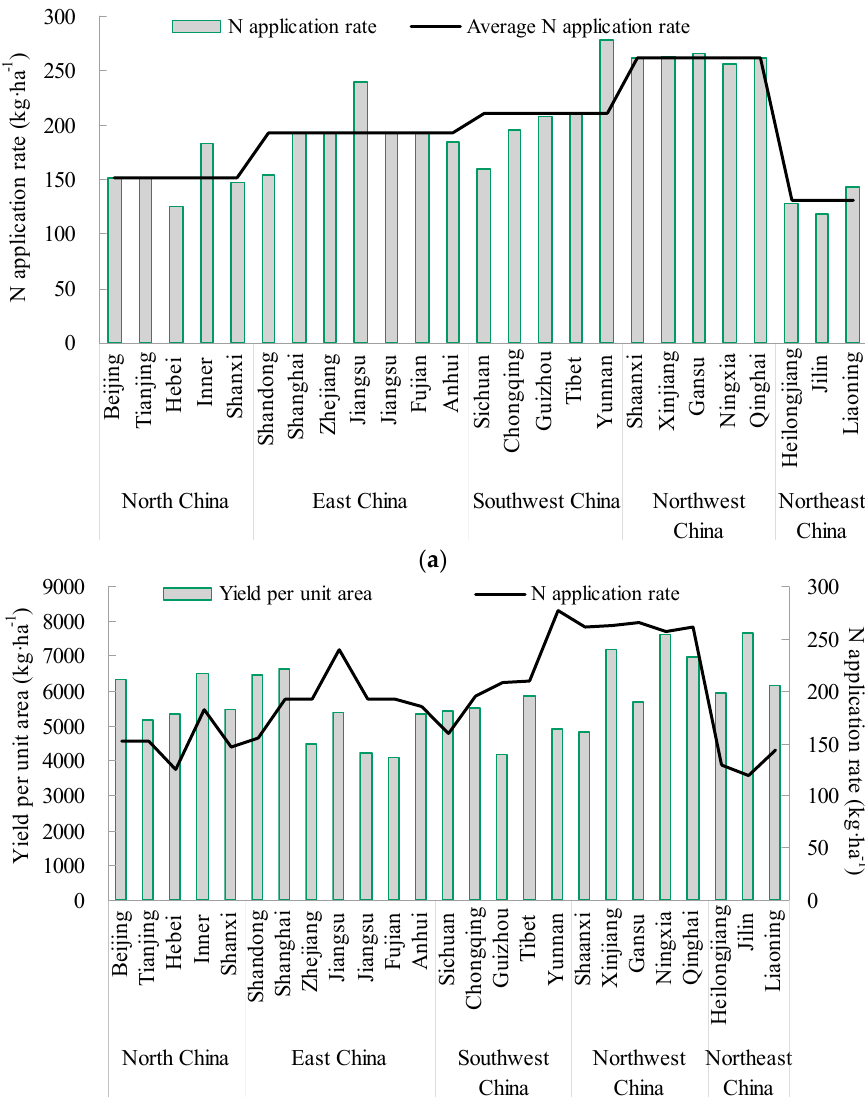
Figure 3. Nitrogen application rate, yield per unit area, and average value of maize in each province from 2012 to 2016.